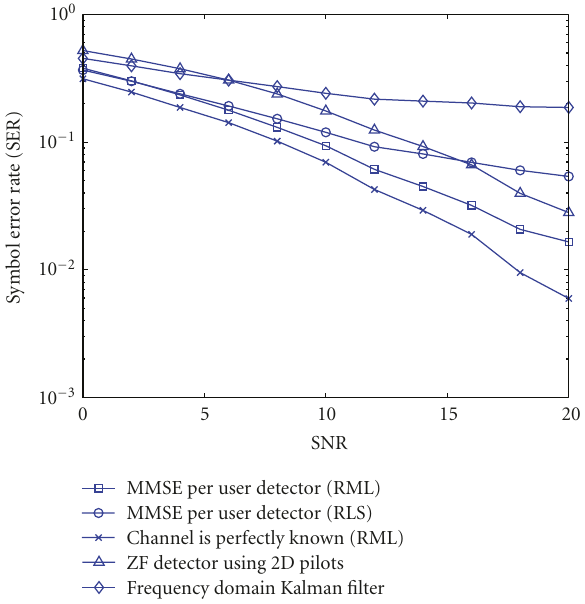
Figure 5: Symbol-error rate (SER) for di ff erent channel-tracking methods as v = 60km/hr ( f d T = 0 . 0516) in urban area.